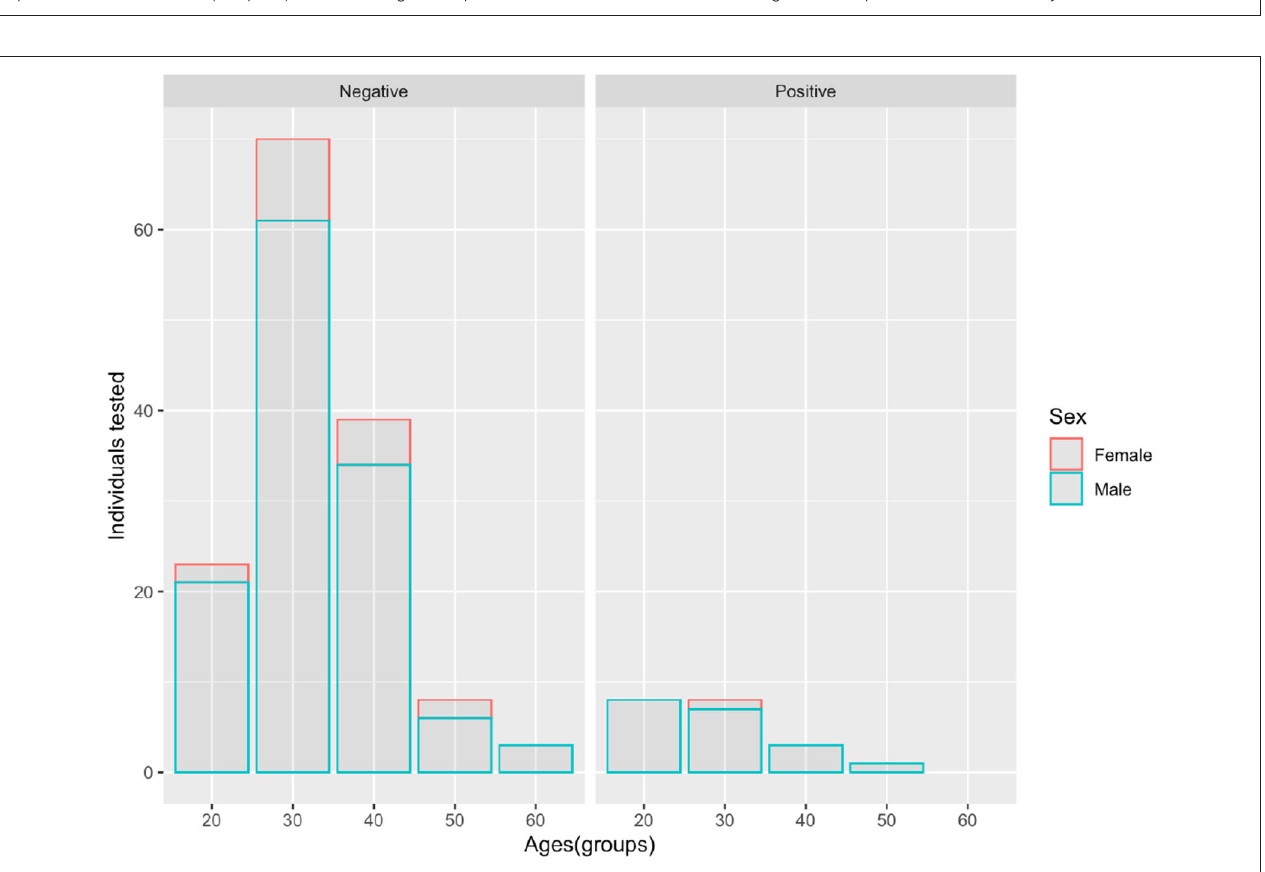
FIGURE 2 | Diagram showing the protocol for viral load calculation in our study using 2019-nCoV N positive control (IDT, IA, USA). The reverse transcription quantitative real-time PCR (RT-qPCR) curves and regression plots are real ones for N1 and N2 viral targets for samples included in this study.